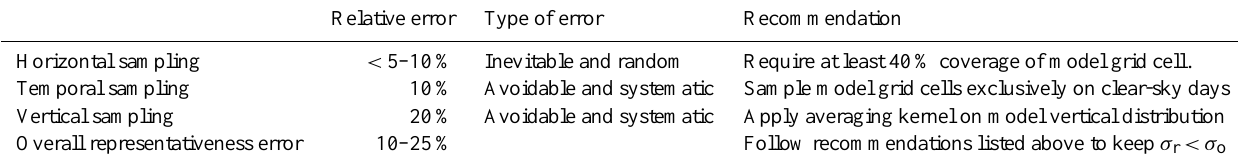
Table 2. Overview of magnitude and nature of various model sampling errors, their contribution to the overall comparison error budget, and ways to avoid them. Based on the GEOS-Chem evaluation with OMI NO 2 retrievals for February and August 2006. Note that these recommendations hold for air pollution applications of UV–Vis satellite retrievals such as model evaluation and top-down emission